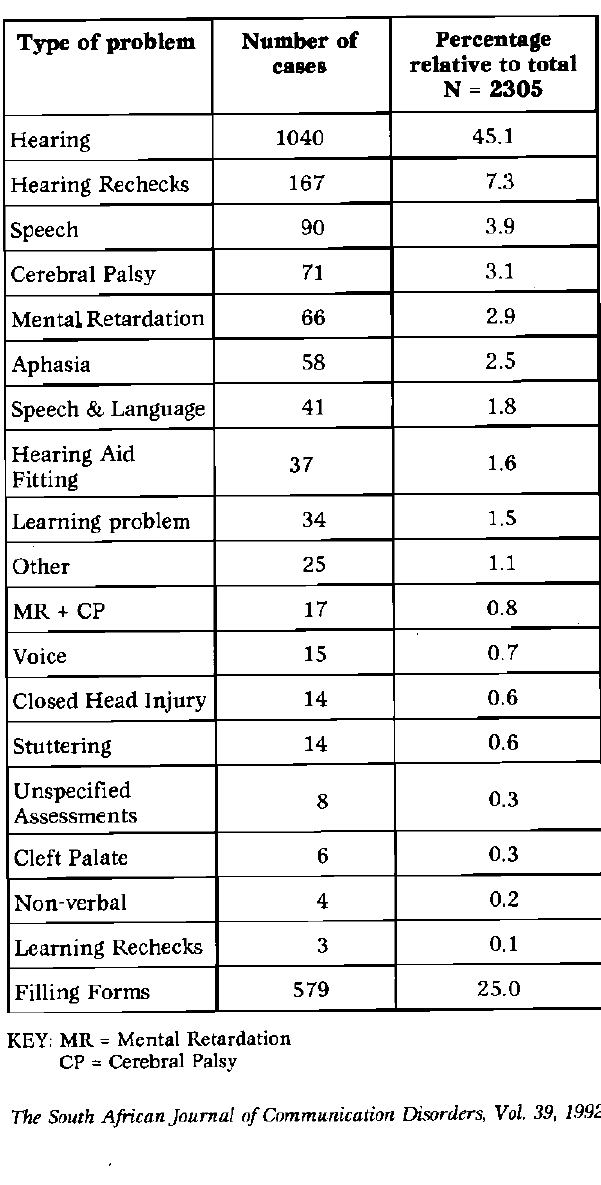
Table 1: Type of Problems and Proportion of Each Rela- tive to the Total Number of Patients seen in β Hospitals